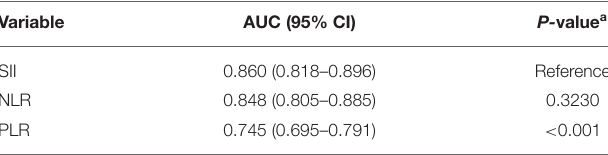
TABLE 3 | Diagnostic values of SII, NLR, and PLR for delayed cerebral